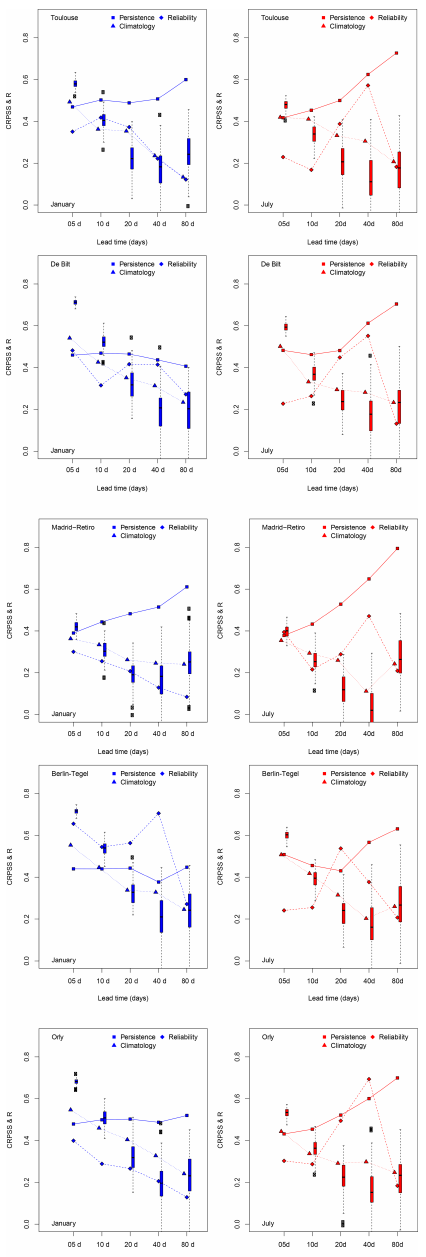
Figure 7. Skill scores for mean daily temperature in Toulouse and De Bilt, for lead times T of 5, 10, 20, 40, and 80 days. Squares indicate CRPSS pers , triangles CRPSS clim , and circles correlation. The diamonds indicate the reliability of CRPS (on the same scale as CRPSS). Blue symbols (left) are for January and red symbols (right) are for July. Triangles are identical for January and July. The boxplots for the correlation indicate the spread across the 100- member ensemble forecasts. Skill scores for temperature in Madrid and Berlin (continued). Skill scores for temperature in Orly (contin-